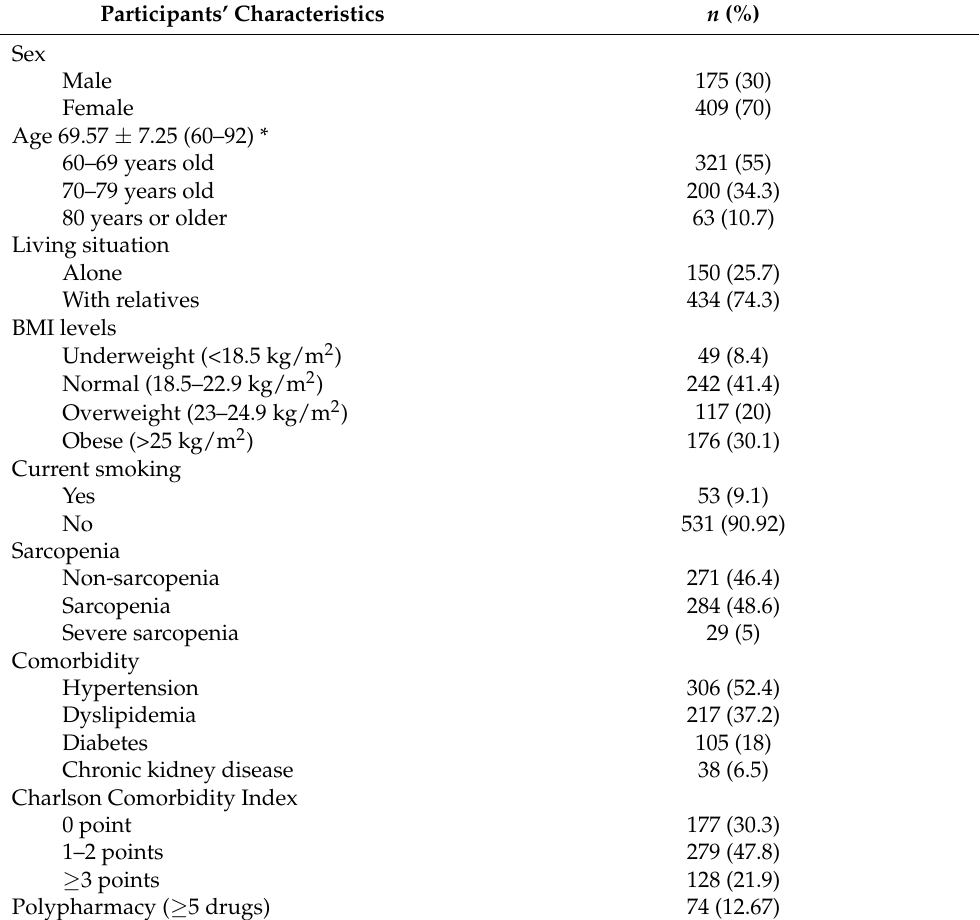
Table 1. Participant characteristics ( n = 584).